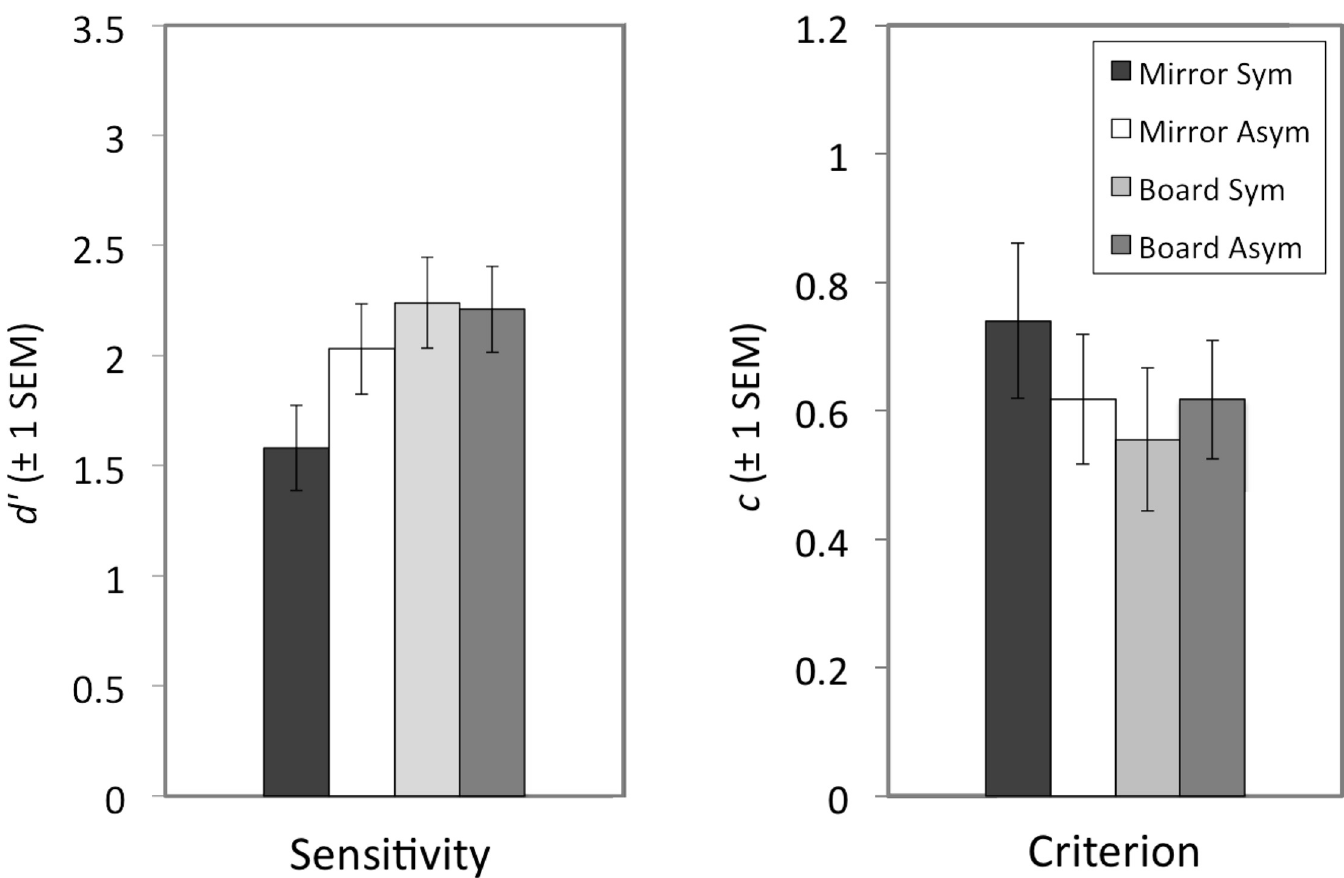
Fig 2. Mirror visual feedback during symmetrical, but not asymmetrical, arm movements impairs tactile gap detection. Sensitivity d ’ data are presented on the left and criterion c data are presented on the right. Error bars represent ± 1